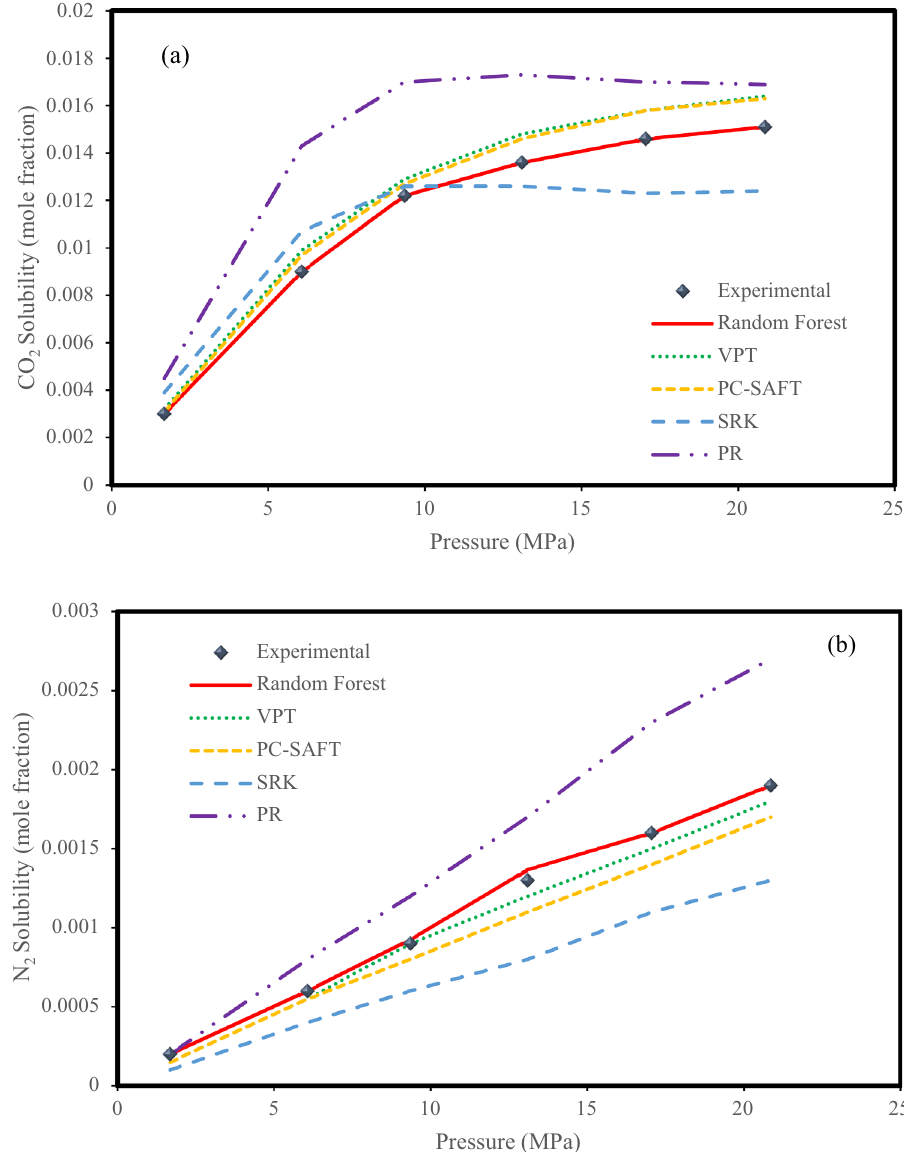
Figure 7. Experimental values 10 with predictions of the EOSs and Random Forest model for the ( a ) CO 2 solubility and ( b ) N 2 solubility in the N 2 (39%) + CO 2 (61%) + H 2 O system at a temperature of 283